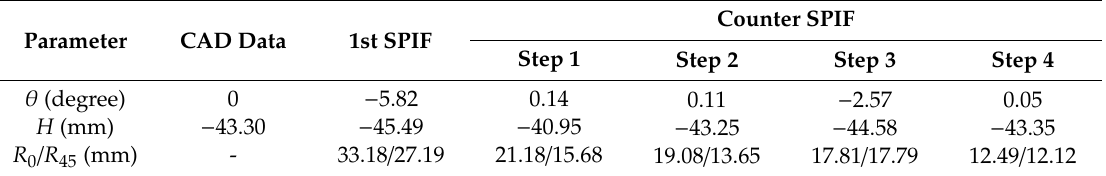
Table 5. Comparison of the circular cup shape according to each compensation step.